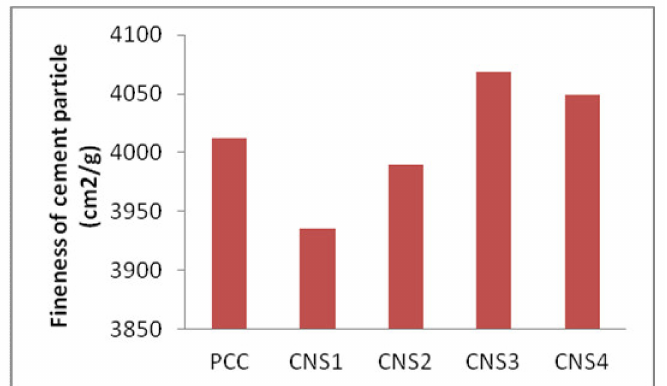
Figure 2. The relationship between the fineness of the cement particle and the percentage of Napa soil composition.